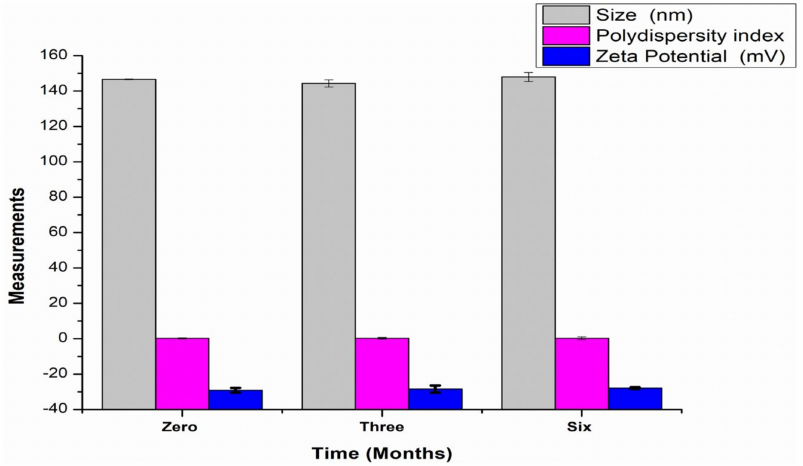
Figure 8. The graphical presentation of stability of transfersomes colloid for a period of six months based of measurement of the particle size, polydispersity index, and zeta potential at room tempera- ture (25 ◦ C) and ambient humidity.